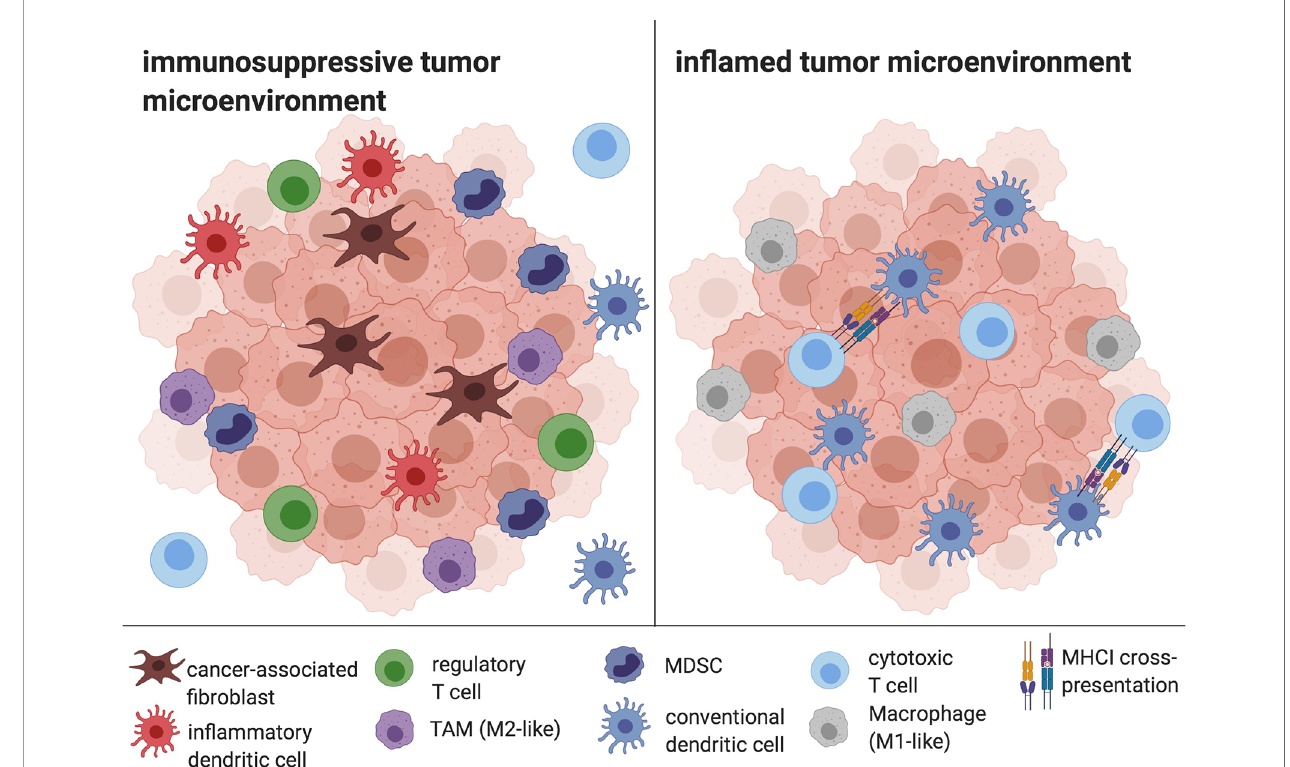
FIGURE 2 | The HCC TME. Cancer-associated fi broblasts, infDCs, TAMs, Tregs and MDSC mediate immune evasion and prevent APC and CD8+ T cell in fi ltration and ef fi cient antigen presentation. In contrast, an in fl amed tumor microenvironment is characterized by the depletion of tolerogenic cells and the in fi ltration of DCs, CD8+ cells and M1-like macrophages, enabling antigen cross-presentation and cytotoxic activity. Created with